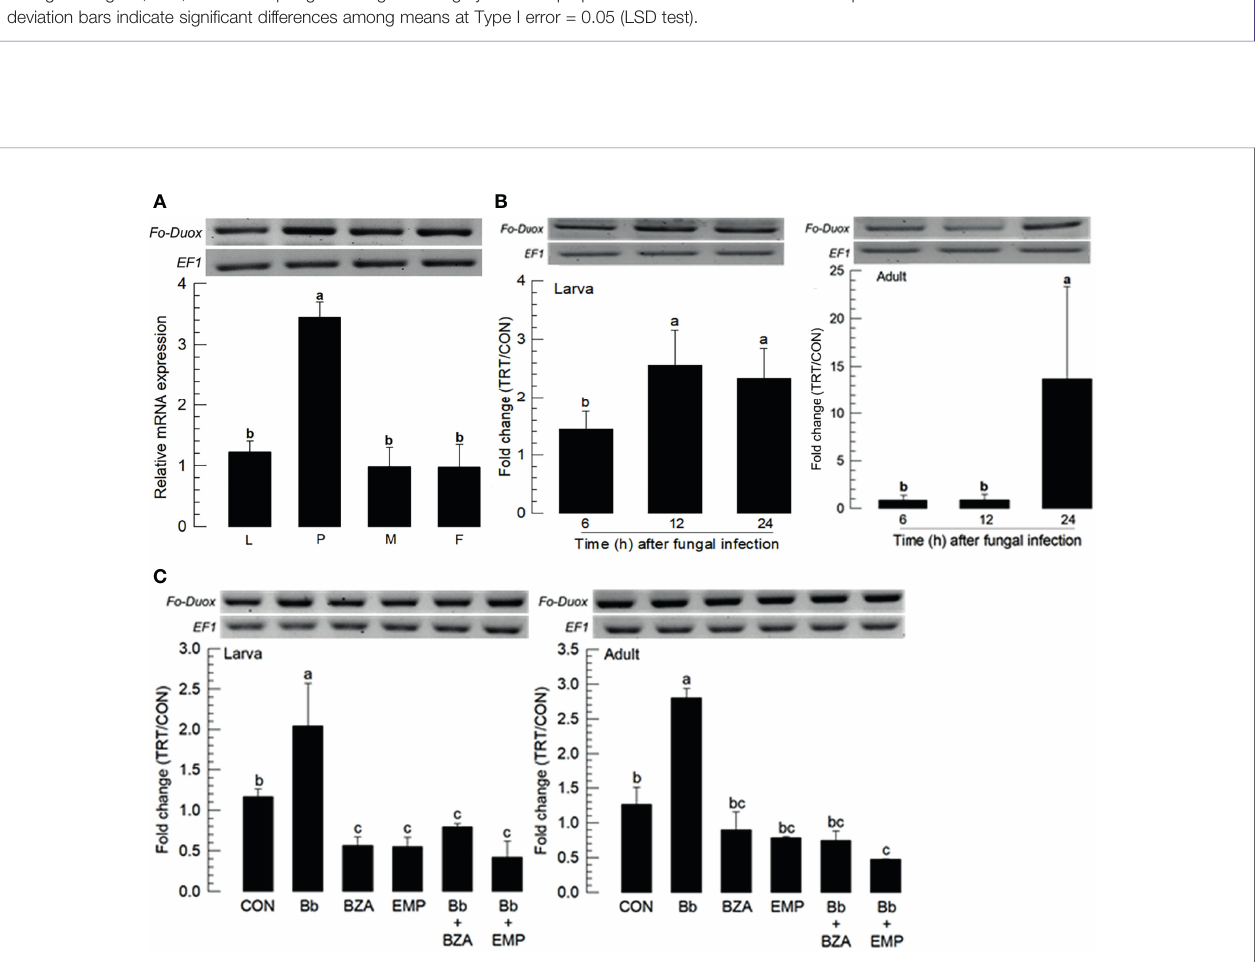
FIGURE 5 | Synergistic effect of EMP or BZA on pathogenicity of B. bassiana to F. occidentalis . (A) Effects of different concentrations of EMP or BZA on the pathogenicity of B. bassiana to larvae and adults. Seed kernels were dipped into 1 mL of the conidial suspension (1×10 5 conidia/mL) containing different concentrations of EMP (0, 10, 100, 500, and 1,000 ppm) or BZA (0, 10, 100, 500, and 1,000 ppm) for 5 min and dried at 25°C for 10 min under sterile condition. Mortality of larvae or adults was recorded for 5 days at 24 h interval. An experimental unit (Petri dish) contained 30 larvae or adults. The Petri dish was sealed with para fi lm. Each treatment was replicated three times. Both experiments were performed under a constant temperature of 25 ± 1°C and 75 ± 5% relative humidity (RH) using a saturated solution of NaCl in a desiccator. EMP or BZA alone did not show any mortality at all concentrations in both developmental stages during this assay. (B) Suppressive effect of EMP on the induction of B. bassiana on the expression of Fo-DSP1 in larvae and adults. To check immunosuppressive activity, B. bassiana (1×10 5 conidia/mL) along with EMP (1,000 ppm) was used as mentioned previously. Fold changes are calculated by ratios of expression levels of immune- challenges ( ‘ TRT ’ ) over naïve ( ‘ CON ’ ) thrips. (C) Suppressive effect of EMP on the induction of B.bassiana on the expressions of four Fo-PLA 2 s ( Fo-sPLA 2 A , Fo- sPLA 2 B , Fo-iPLA 2 A , and Fo-iPLA 2 B ) in L2 larvae or adults upon challenge with B. bassiana in larvae and adults. To check the immunosuppressive activity, B. bassiana (1×10 5 conidia/mL) along with EMP (1,000 ppm) was used as mentioned previously. RNA samples were collected from the whole body extracts of larvae (~100) or adults (~100) for each treatment at 24 h post-infection. (D) Inhibitory effect of EMP or BZA on PLA 2 enzyme activity in larvae or adults. Protein samples were collected from the whole body extracts of larvae (~100) or adults (~100) for each treatment at 24 h post-infection. Each treatment was replicated with three biologically independent enzyme preparations using different larval or adult samples. (E) Inhibitory effect of EMP or BZA on the expression of Fo-PGES2 in larvae or adults. To check immunosuppressive activity, B.bassiana (1×10 5 conidia/mL) along with EMP (1,000 ppm) or BZA (1,000 ppm) was used as mentioned previously. RNA samples were collected from the whole body extracts of larvae (~100) or adults (~100) for each treatment at 24 h post-infection. The expression of an endogenous gene, EF1 , con fi rms equal gel loading and integrity of cDNA preparation. Each measurement was replicated three times. Different letters above standard deviation bars indicate signi fi cant differences among means at Type I error = 0.05